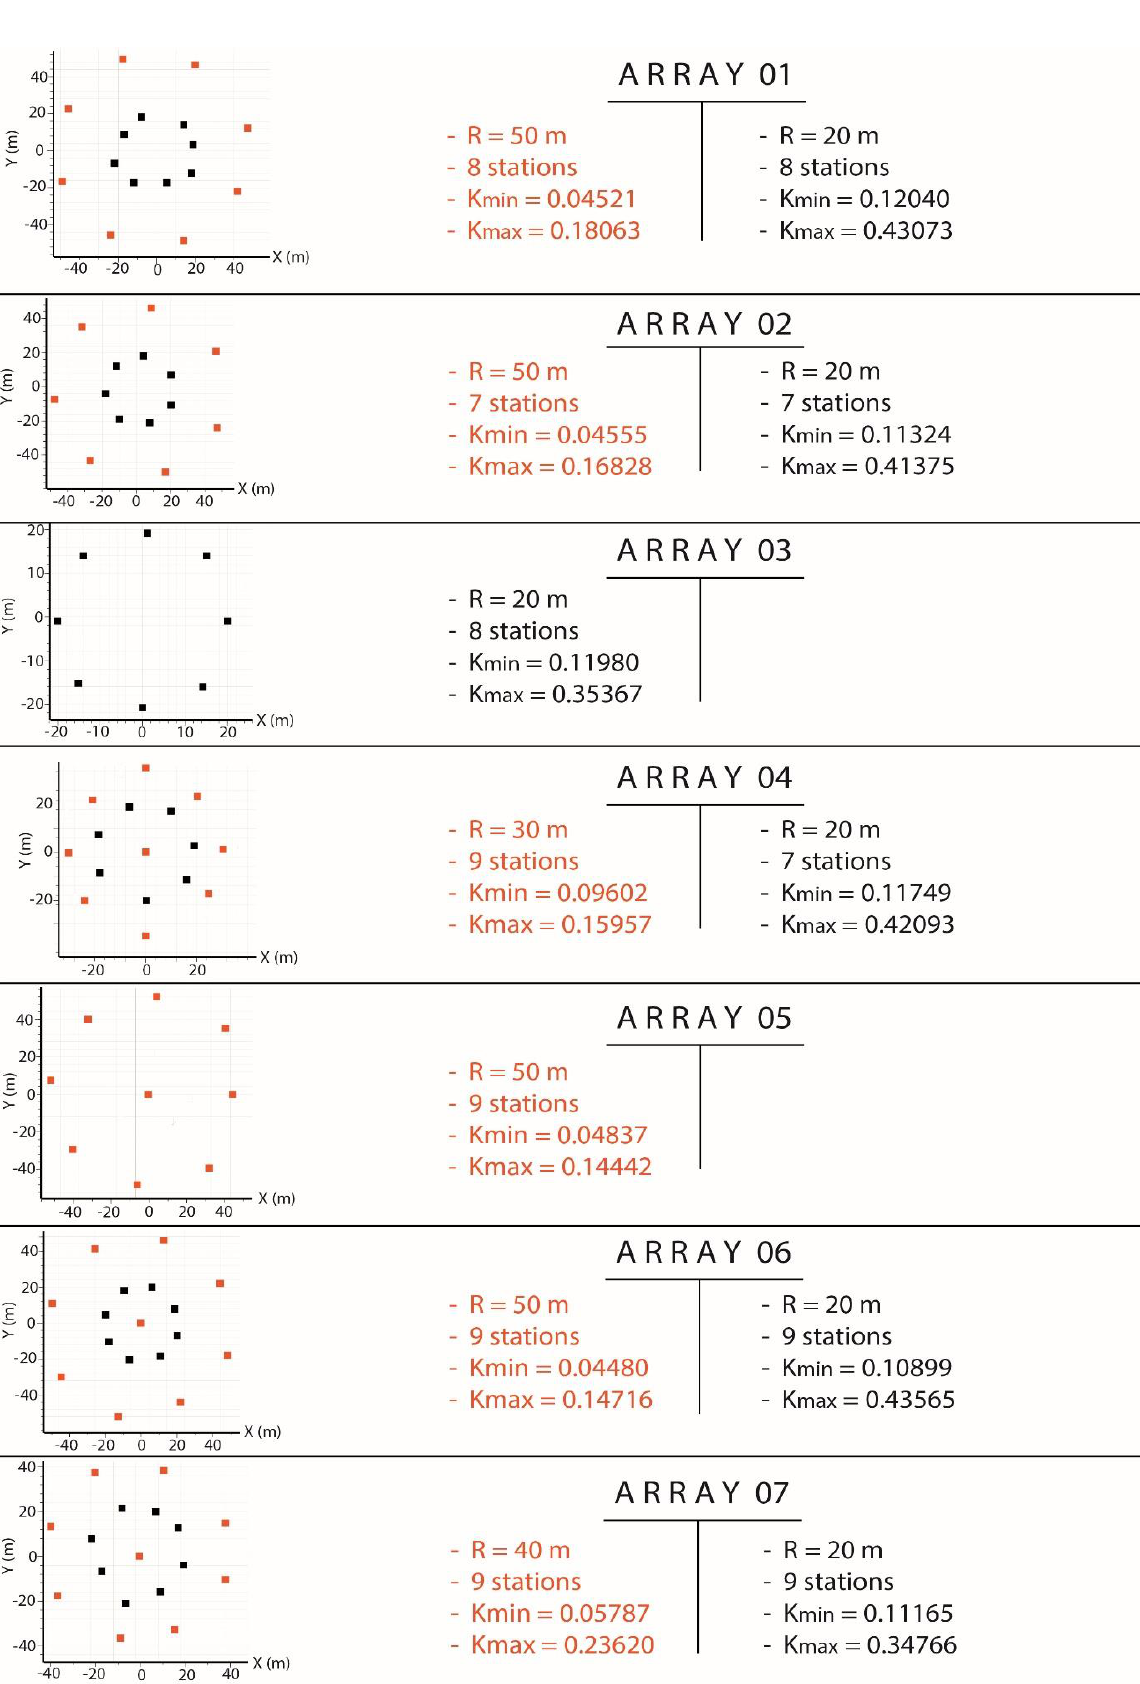
Figure 8. Theoretical wavenumbers obtained at each array recording site.